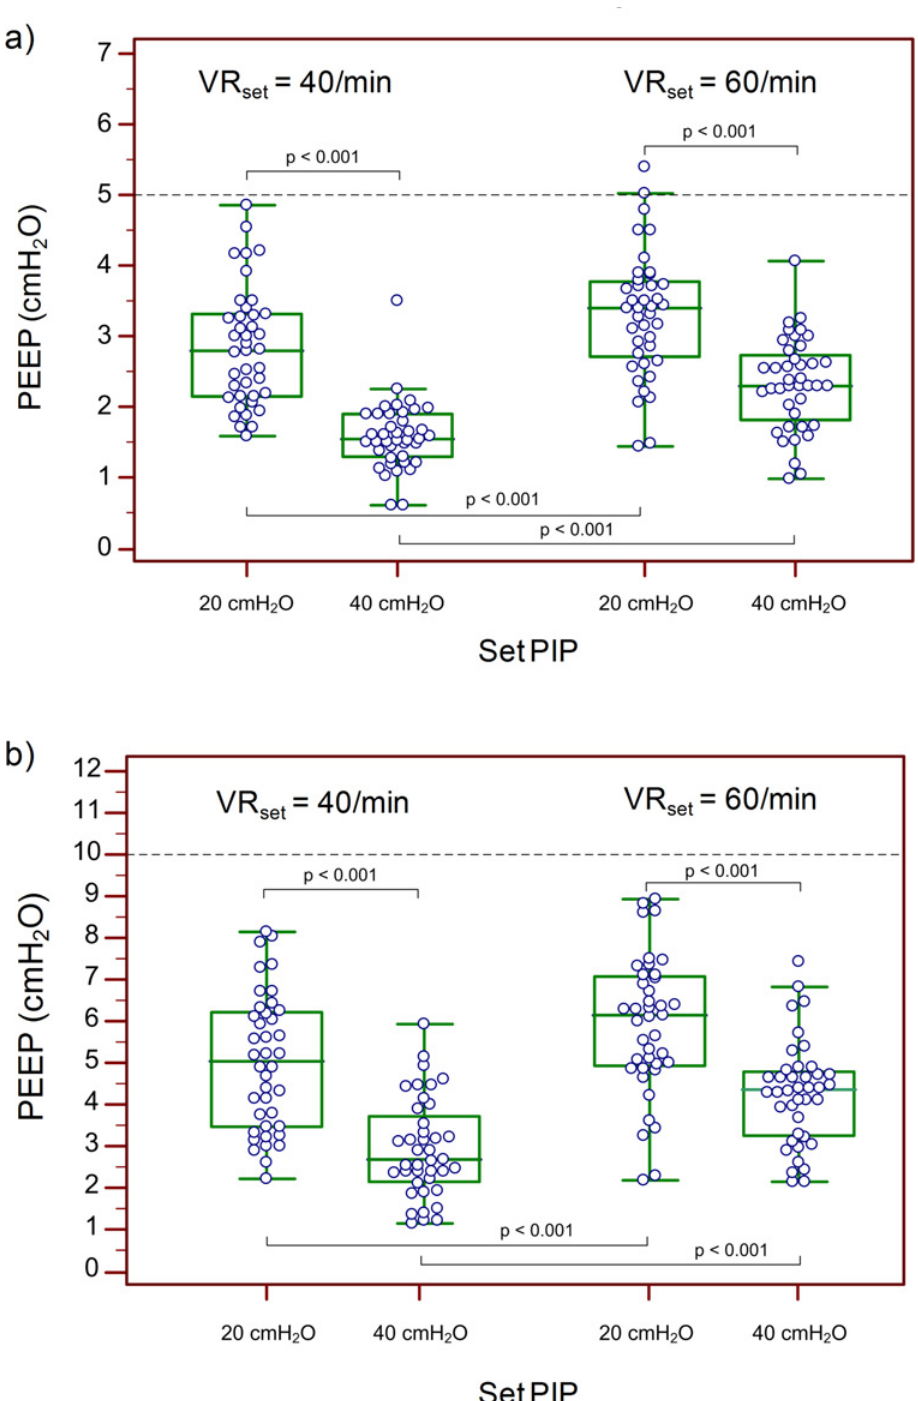
Fig 4. Effect of PIP and VR. Effect of PIP and VR on the delivered PEEP for a PEEP setting of a) 5 cmH 2 O and b) 10 cmH 2